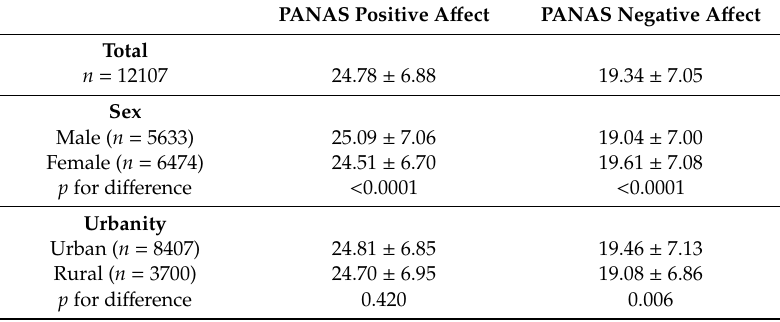
Table 3. Changes in the Positive and Negative Affect Schedule (PANAS) in Chinese residents aged 18 years and over during home quarantine induced by COVID-19, 2020.